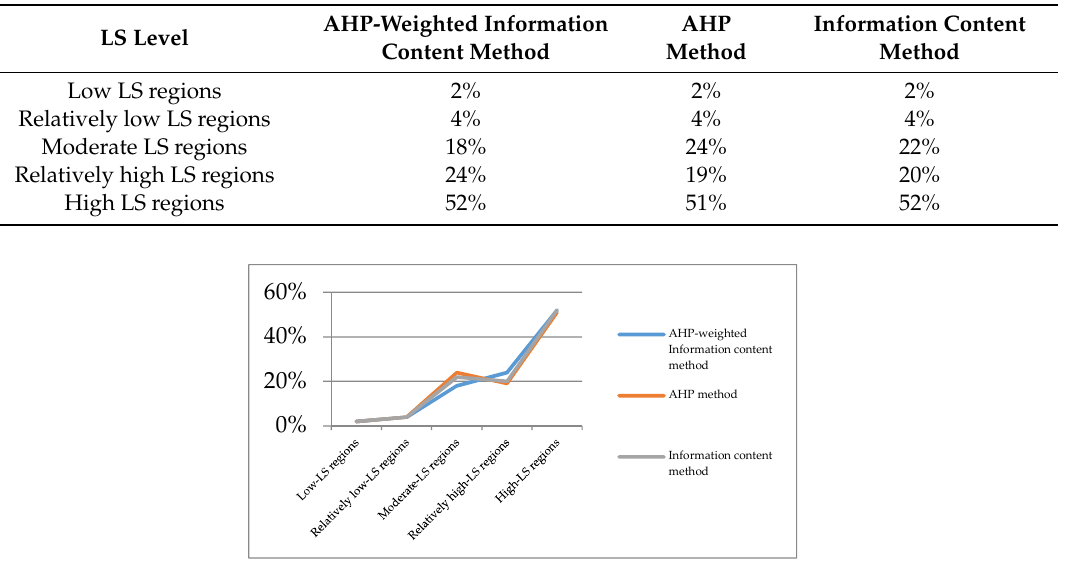
Table 4. Comparison of the proportions of landslide sites determined using the three methods.